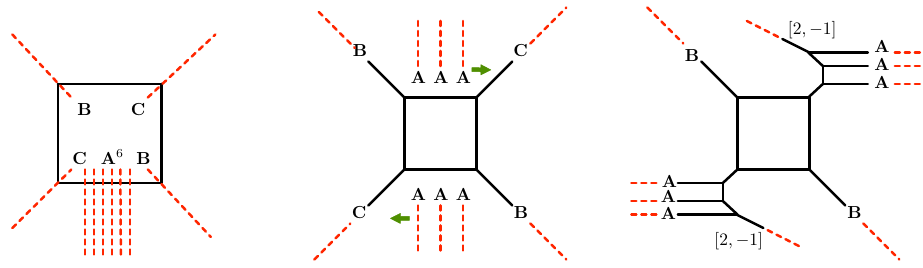
Figure 4 . Various 7-brane configurations for 5d SU(2) + 6 F and a 5-brane web obtained via Hanany-Witten moves. The branch cuts of 7-branes are denoted by dotted lines.